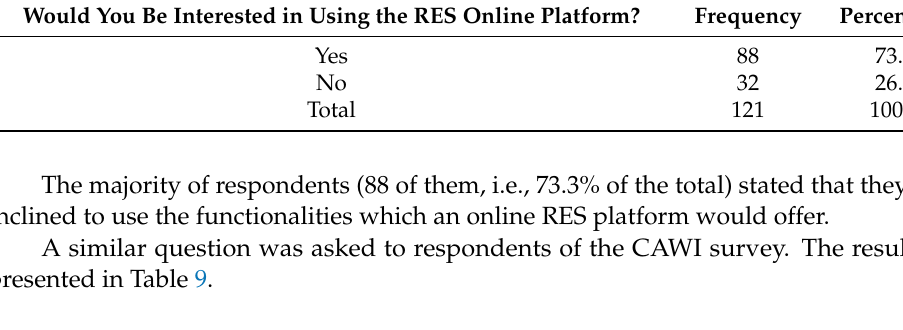
Table 9. Declarations of respondents of the CAWI survey related to the use of the RES online platform. Would You Be Interested in Using the RES Online Platform?